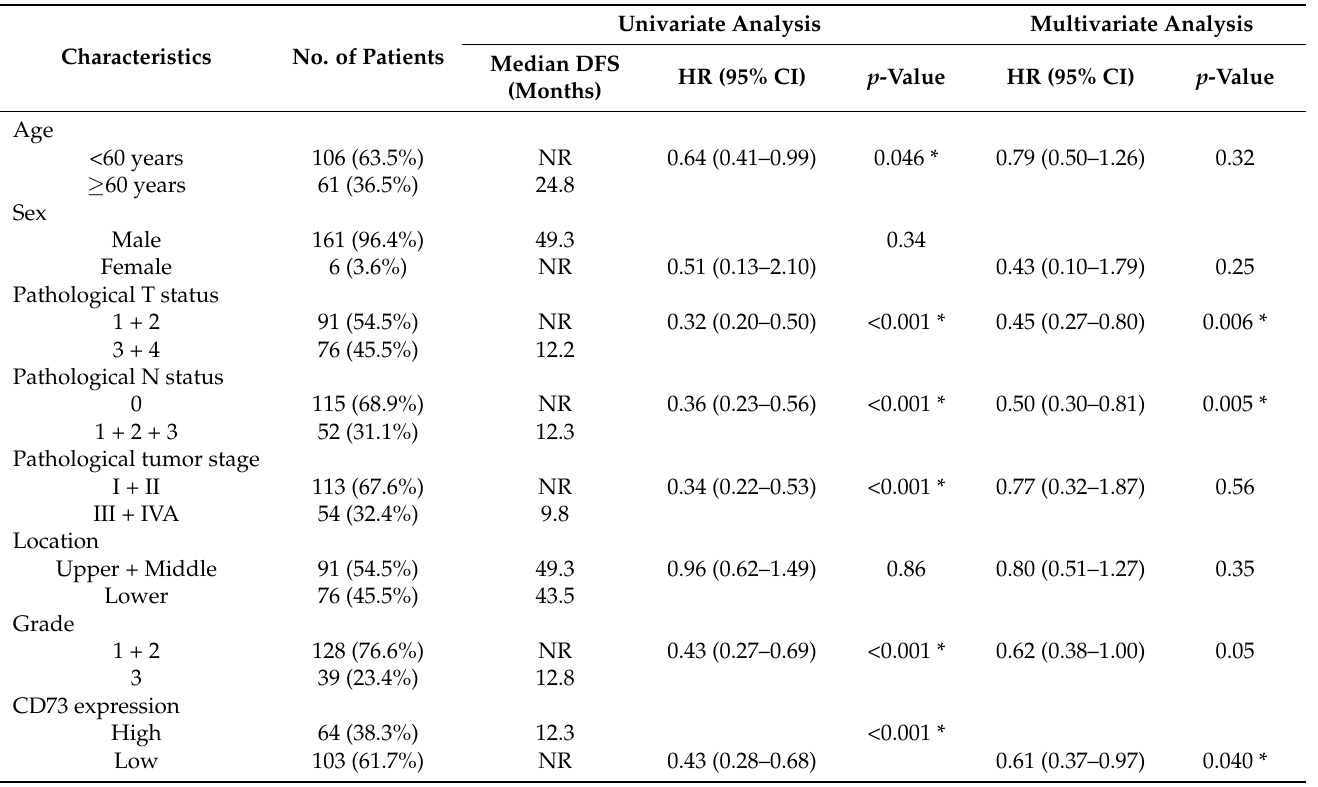
Table 2. Univariate and multivariate analysis of disease-free survival (DFS) in 167 patients with esophageal squamous cell carcinoma receiving surgical resection.